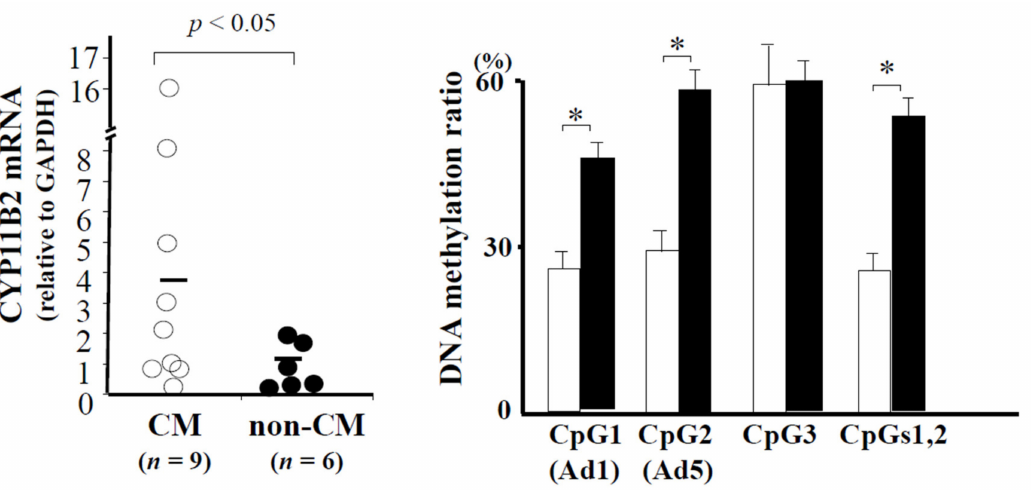
Figure 6. The CYP11B2 mRNA level was significantly increased in the heart of HCM. The CpG methylation ratios of the CYP11B2 promoter was significantly decreased in the heart of HCM. * p < 0.05 compared to non-HCM.